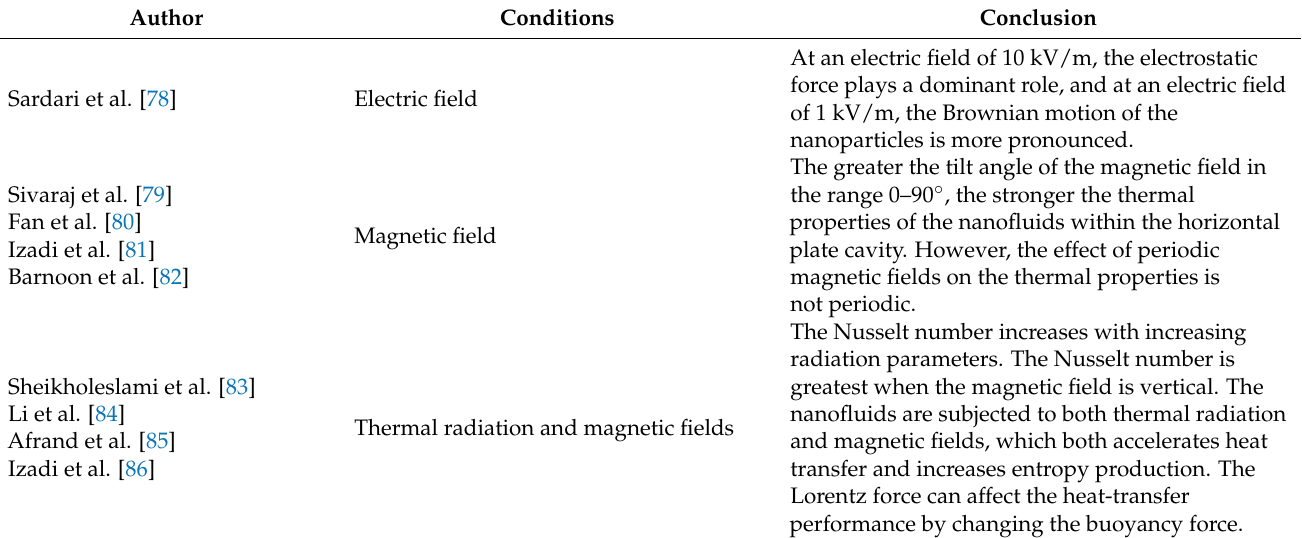
Table 3. Simulation of electric and magnetic fields and radiation on the flow properties of nanoflu- ids.